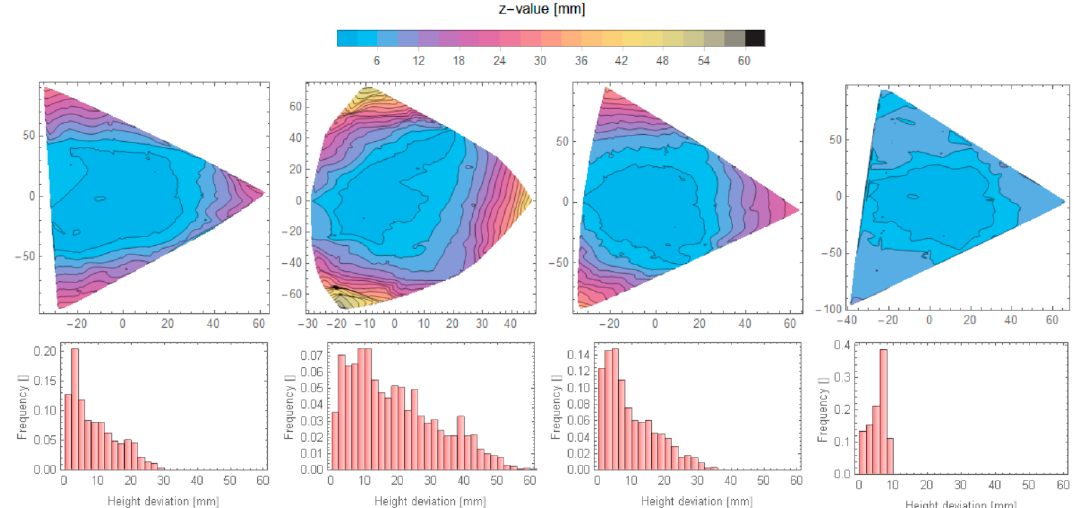
Figure 6. Representation in the same color scale after sails opening: Configurations 1, 2, and 3 lack in complete opening occurs while, in Configuration 4, the sail is mainly flat.